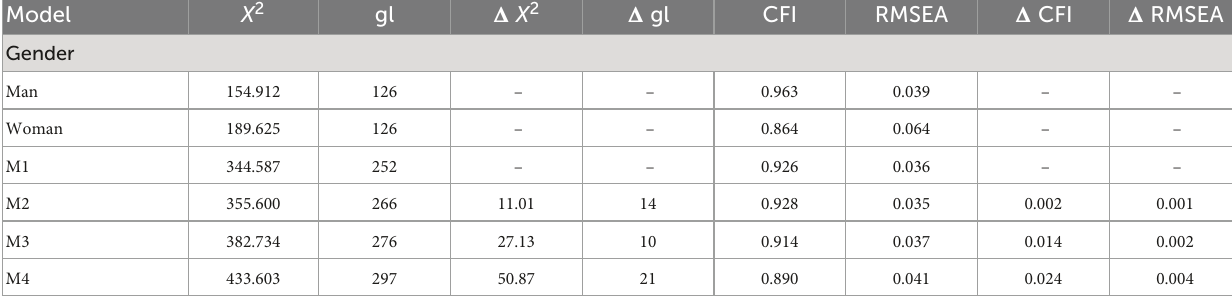
TABLE 3 Measurement invariance of the model based on gender.